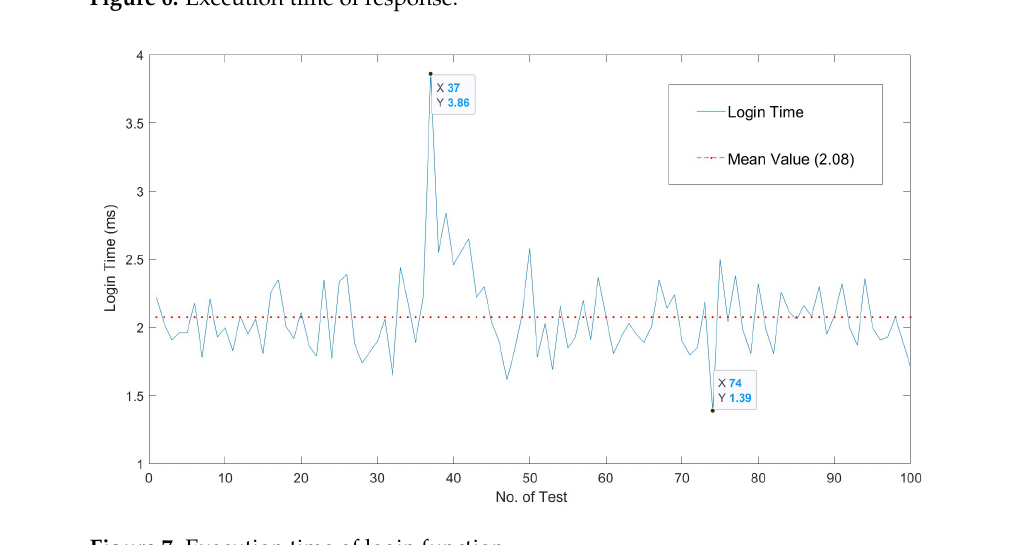
Figure 6. Execution time of response.